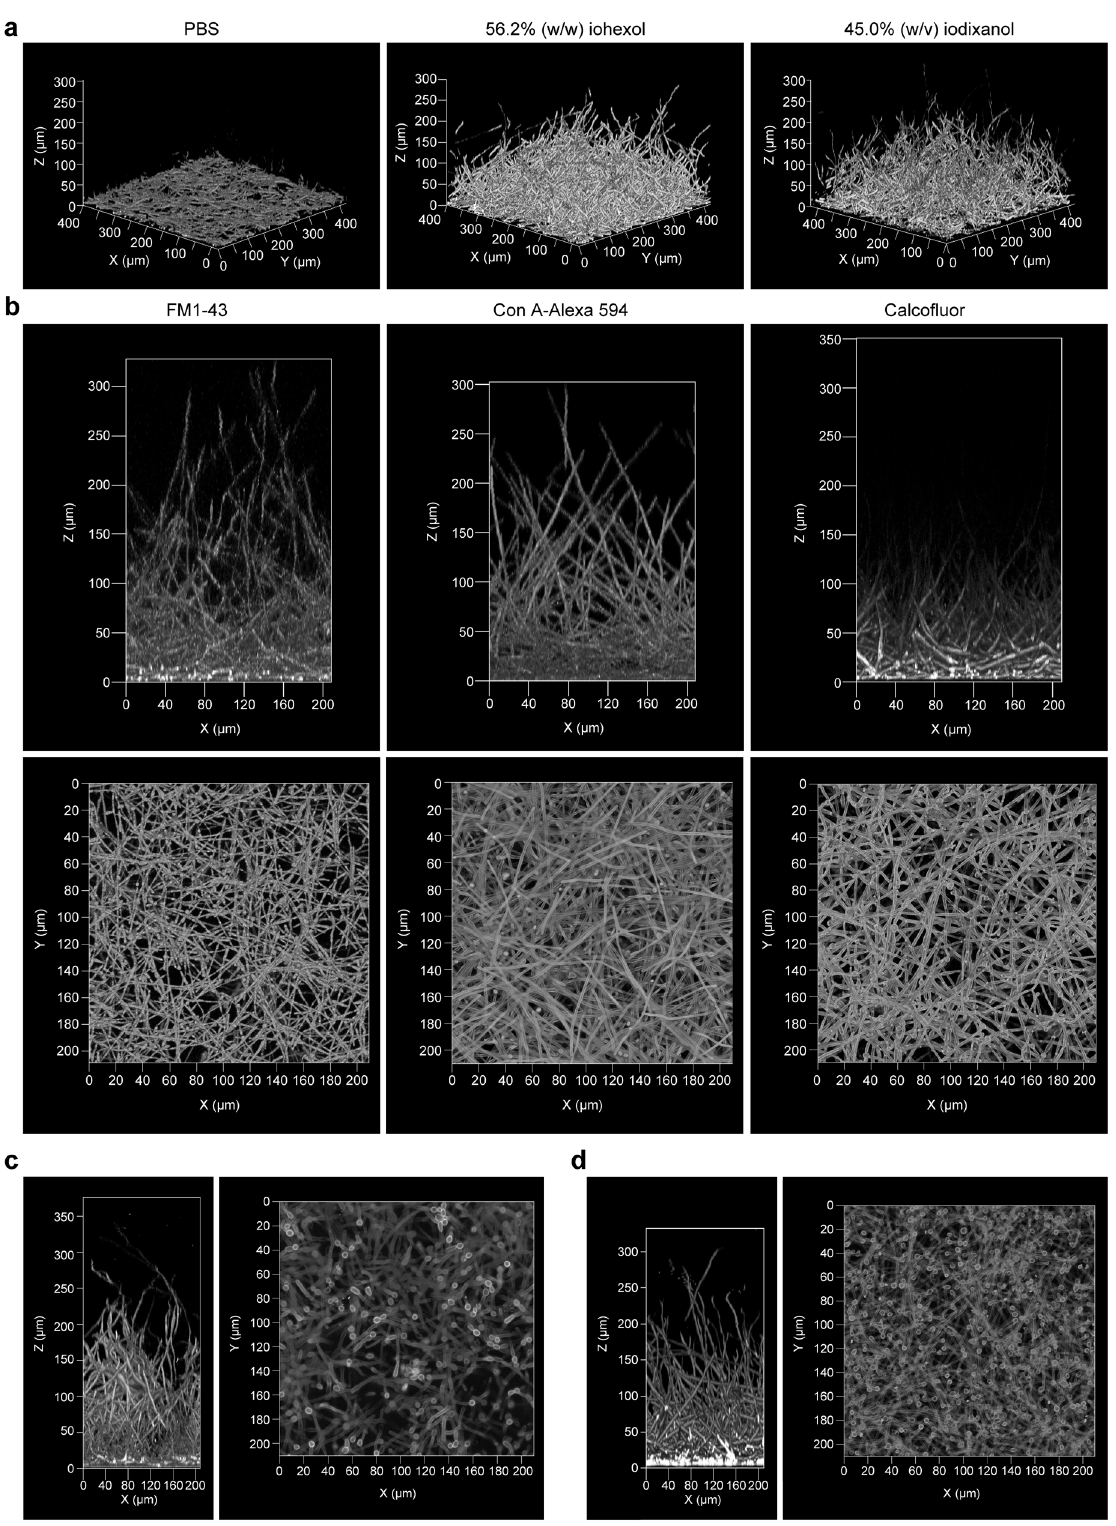
Fig. 7 Application of the iCBio fi lm method to a C. albicans bio fi lm. a 3D images of C. albicans bio fi lms stained with FM1-43. The stained bio fi lms were soaked in the indicated solutions and observed using an LSM880 microscope with a ×20 objective lens. b Side and bottom views of C. albicans bio fi lms stained with indicated dyes. c Side and bottom views of C. albicans bio fi lms formed under the conditions employed in the Douglas model 45 . d Side and bottom views of C. albicans bio fi lms grown under similar conditions in a and b , but with an initial number of C. albicans cells of 10 7 CFU/mL. The bio fi lms were stained with Con A-Alexa 594, soaked in 45.0% (w/v) iodixanol, and observed using the LSM880